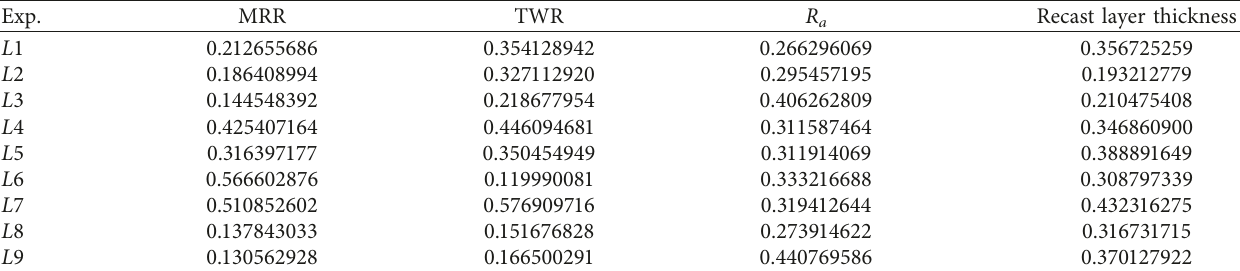
Table 14: Normalized decision matrix.